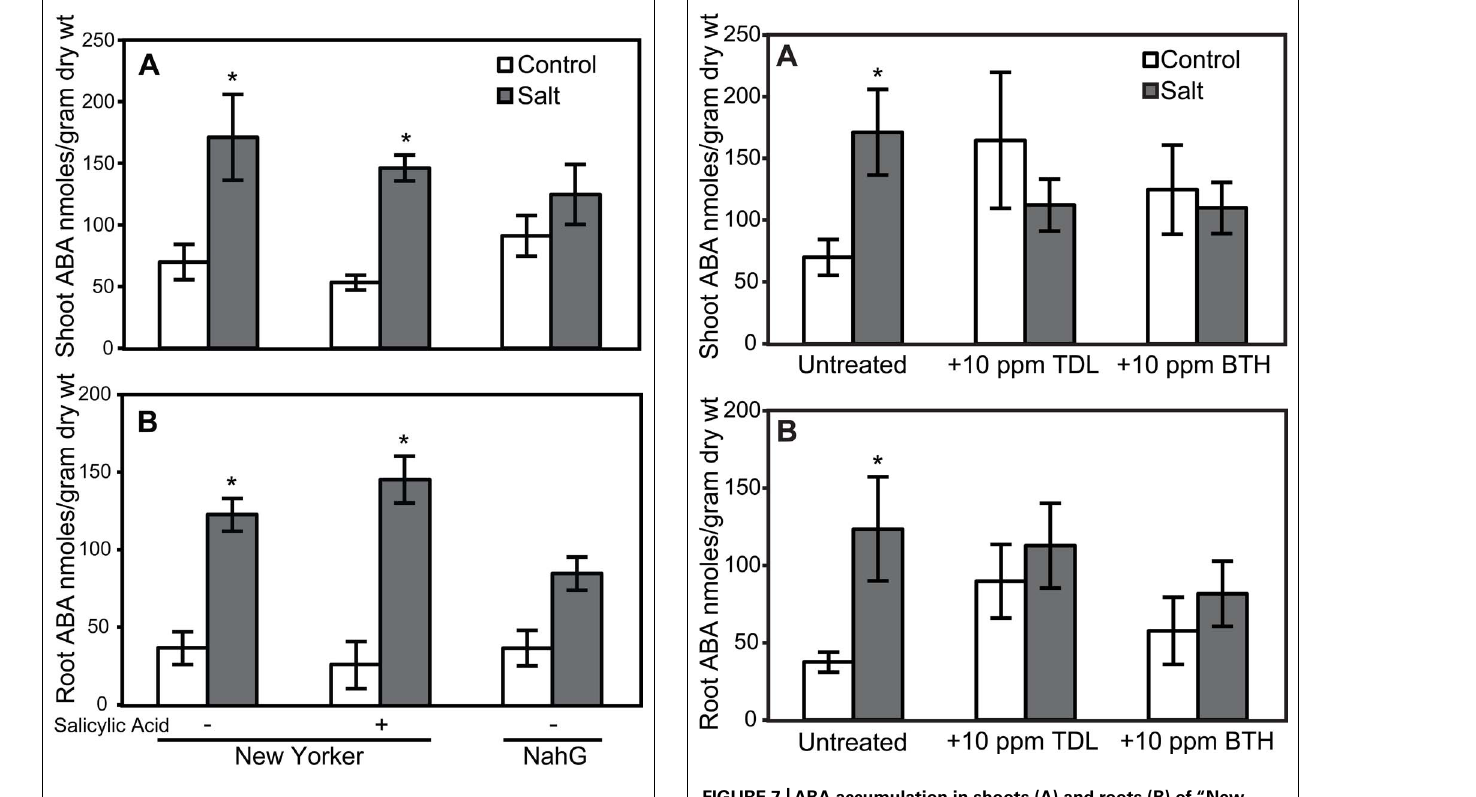
FIGURE 6 |ABA accumulation in shoots (A) and roots (B) of salt-stressed and non-stressed tomatoes with altered salicylic acid. ABA levels in the roots of “NewYorker” and NahG seedlings, non-stressed (control) and 18 h salt-stressed (0.2 M NaCl and 0.02 CaCl 2 ). + = seedling roots were treated with SA (62 μ M) for 1 week prior to ABA measurement. Bars represent the means ± SE from five experiments ( n = 15). Asterisks indicate significant differences over the “NewYorker” control by Dunnett’s test α = 0.05).